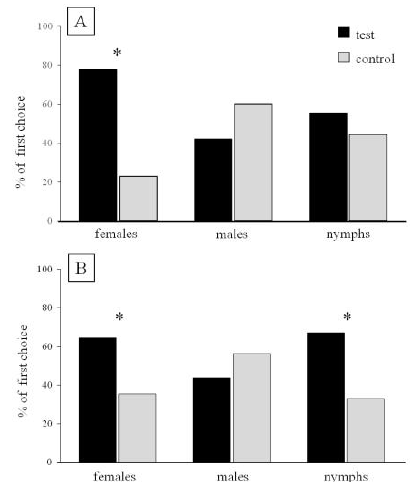
Figure 2. (A) Response of Bagrada hilaris individuals to ( E )-2-octenyl acetate (test) vs. the solvent (control) (females n = 46; males n = 36; nymphs n = 56); ( B) Response of B. hilaris individuals to ( E )-2-octenyl acetate in the presence of Brassica oleracea seedlings (test) versus B. oleracea seedlings alone (control) (females n = 62; males n = 66; nymphs n = 61); * p < 0.05.